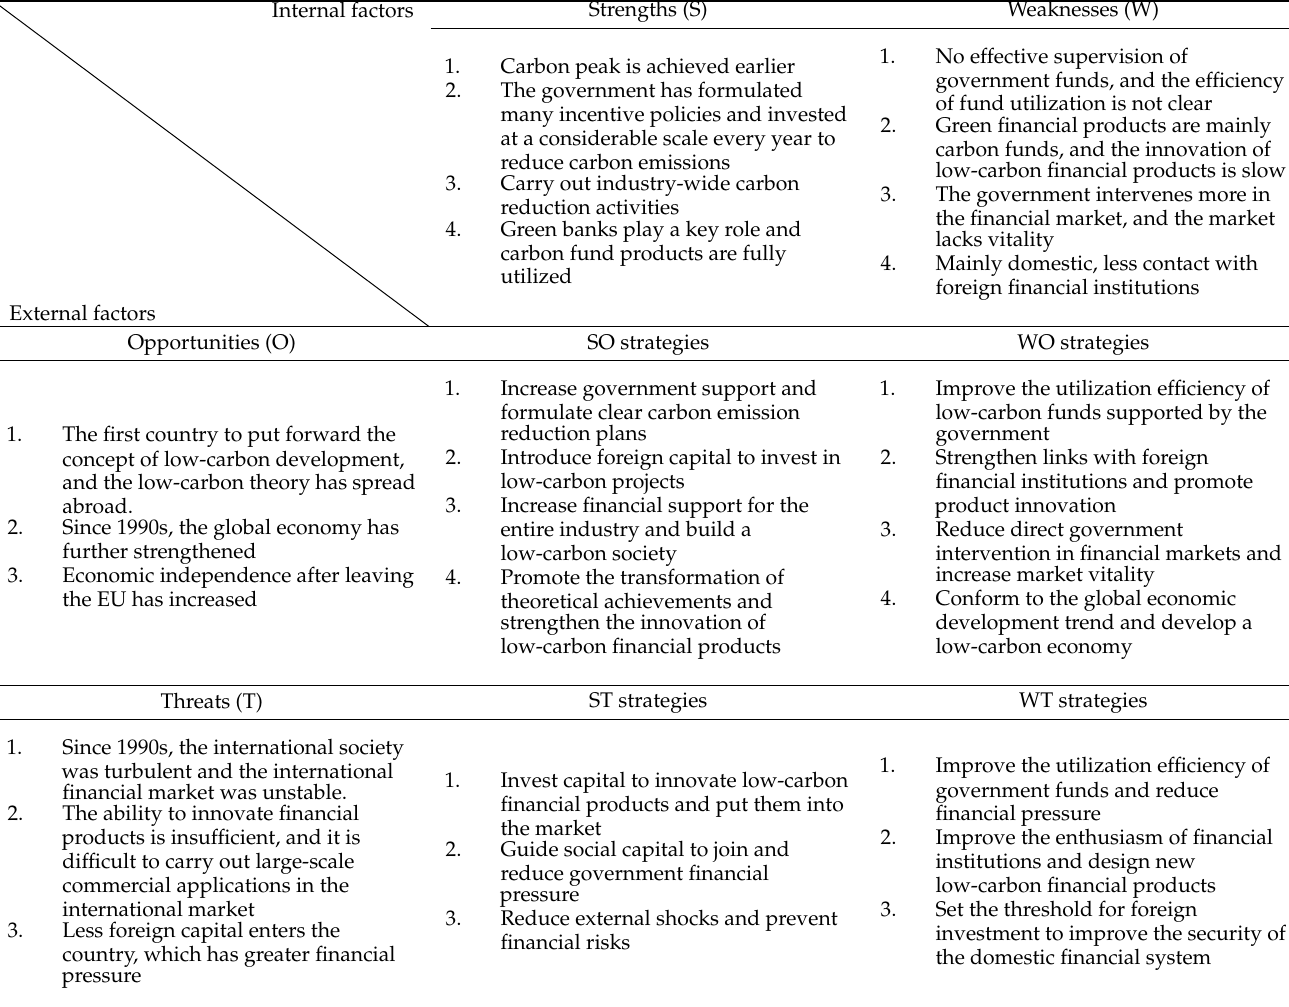
Table 1. SWOT analysis of financial measures to reduce carbon emissions in